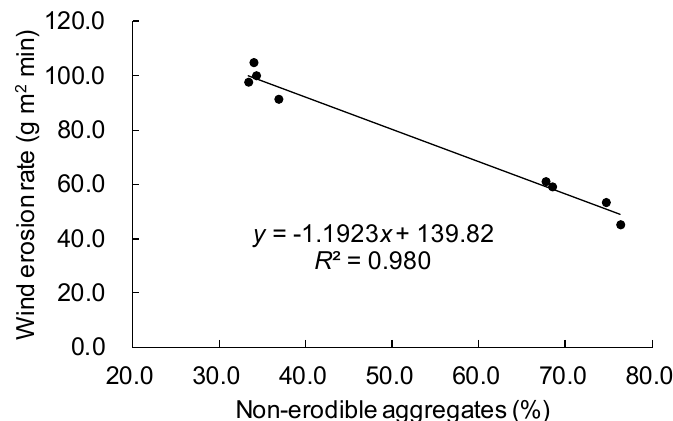
Figure 2. Relationship between soil wind erosion rate and percent mass of non-erodible soil particles, across cropping systems and tillage methods during two years.